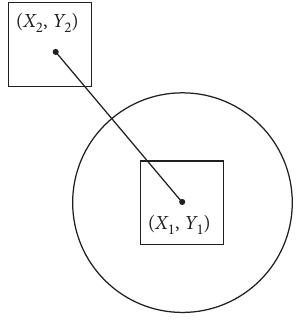
Figure 4: The schematic diagram of distance between current CTU and central